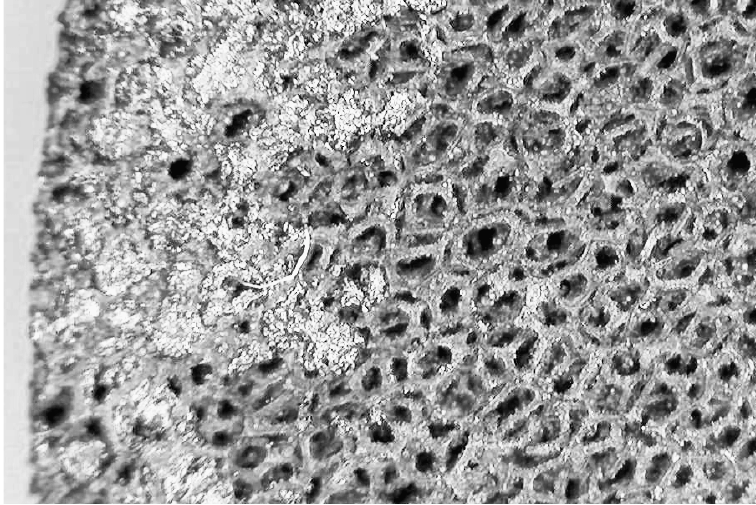
Figure 8. Multiple cycle preparation process with 5% sodium permanganate solution (sample P2S1—triple process with 5% solution of NaMnO 4 ).